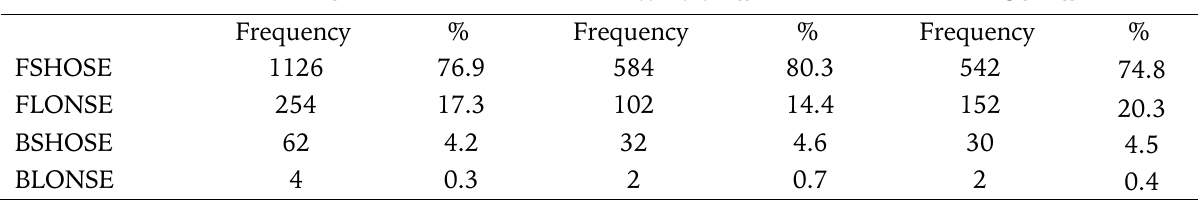
Results of analysis of serve type of all sample and according result outcome (winners/losers) ALL